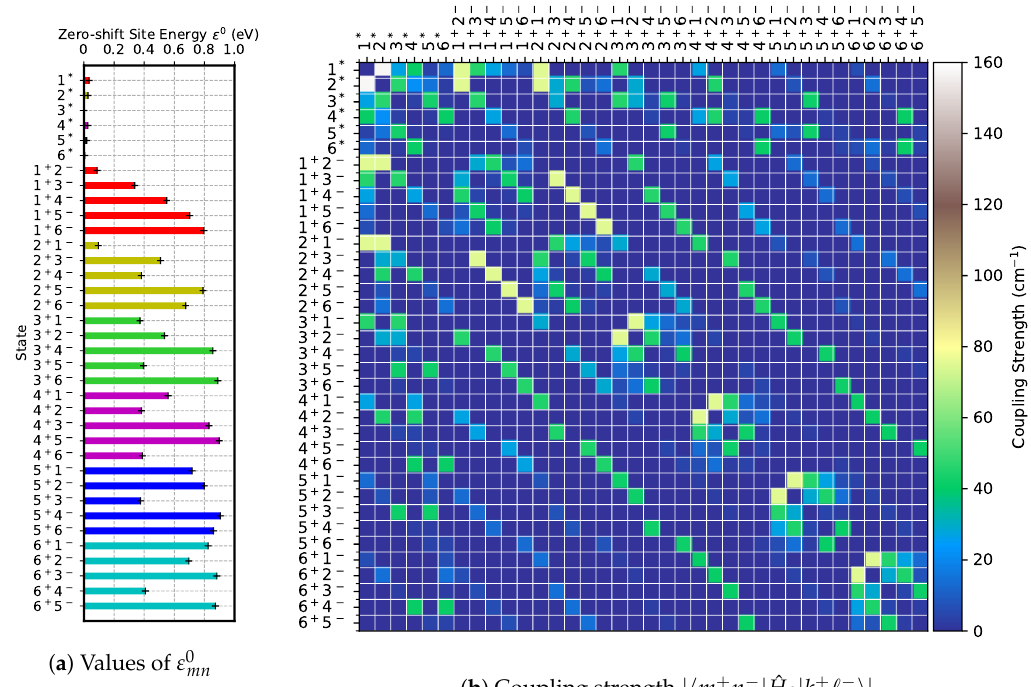
Figure 5. ( a ) The zero-shift site energy ε 0 mn in units of eV. All of the values are subtracted by 14,800cm − 1 = 1.835eV. The color code corresponds to that of Figure 4 for the pigment at which the hole resides. ( b ) The coupling strength between states in units of cm − 1 which are the magnitudes of the off-diagonal elements ( | m + n − (cid:105) (cid:54) = | k + (cid:96) − (cid:105) ) of the system Hamiltonian given earlier in Equation